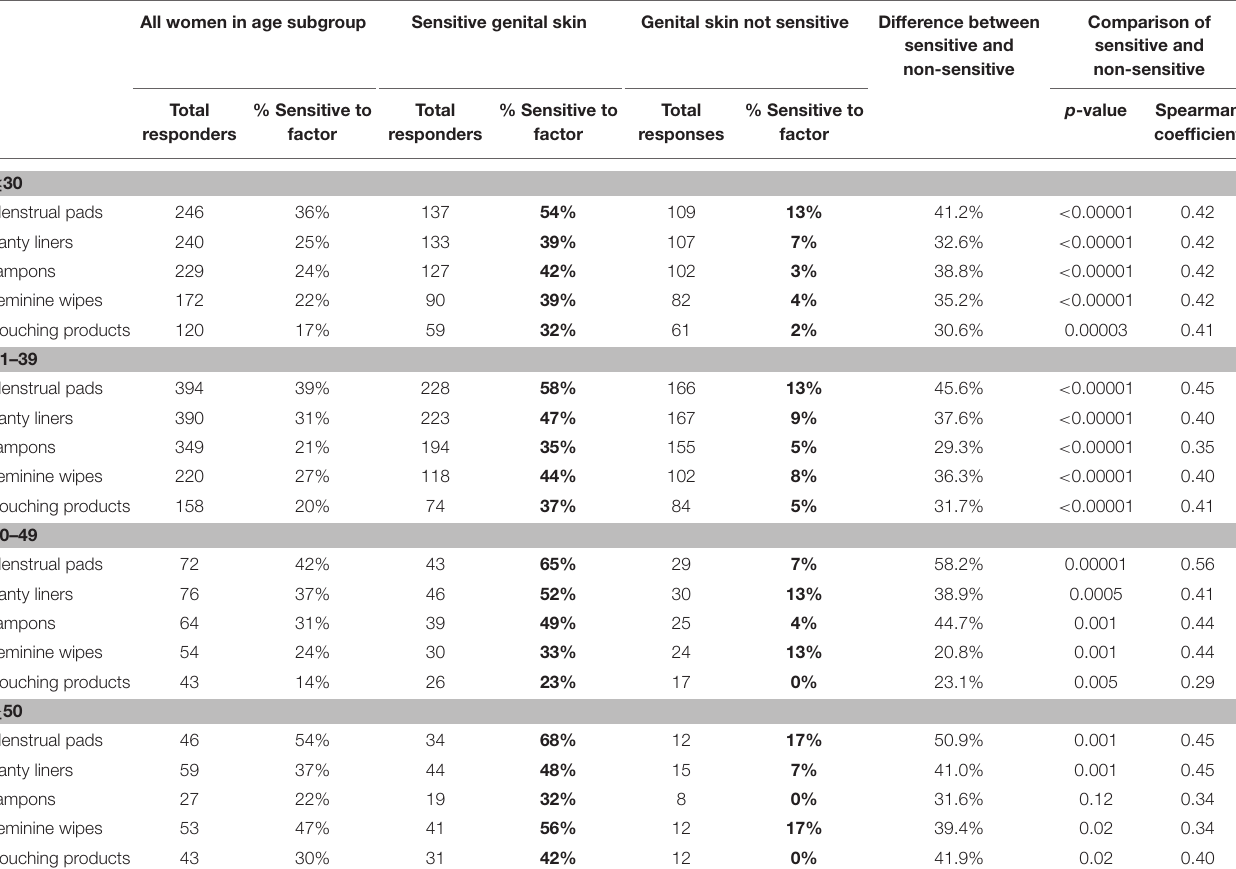
TABLE 3 | Perceptions about feminine products perceived to trigger skin responses among women of different age groups. All women in age